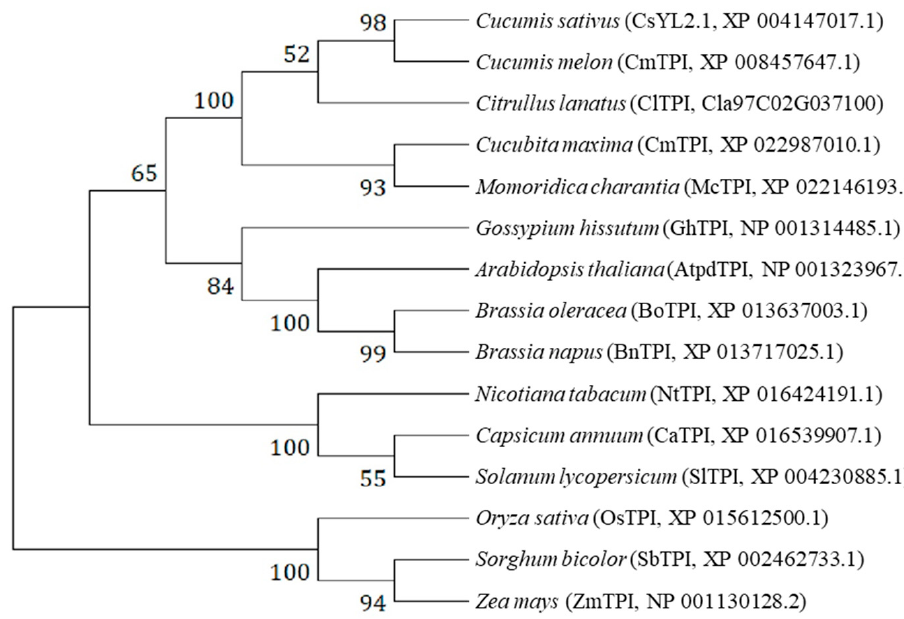
Figure 3. Phylogenetic tree of CsYL2.1 protein in cucumber and its orthologs in other species. There is no specific information on TPI or pdTPI for other species except that studies in Arabidopsis thaliana shows it to be pdTPI. The phylogenetic tree was constructed via the neighbor-joining method built in MEGA X. Numbers indicate the percentage of replicate trees in which the associated taxa clustered together in the bootstrap test (1000